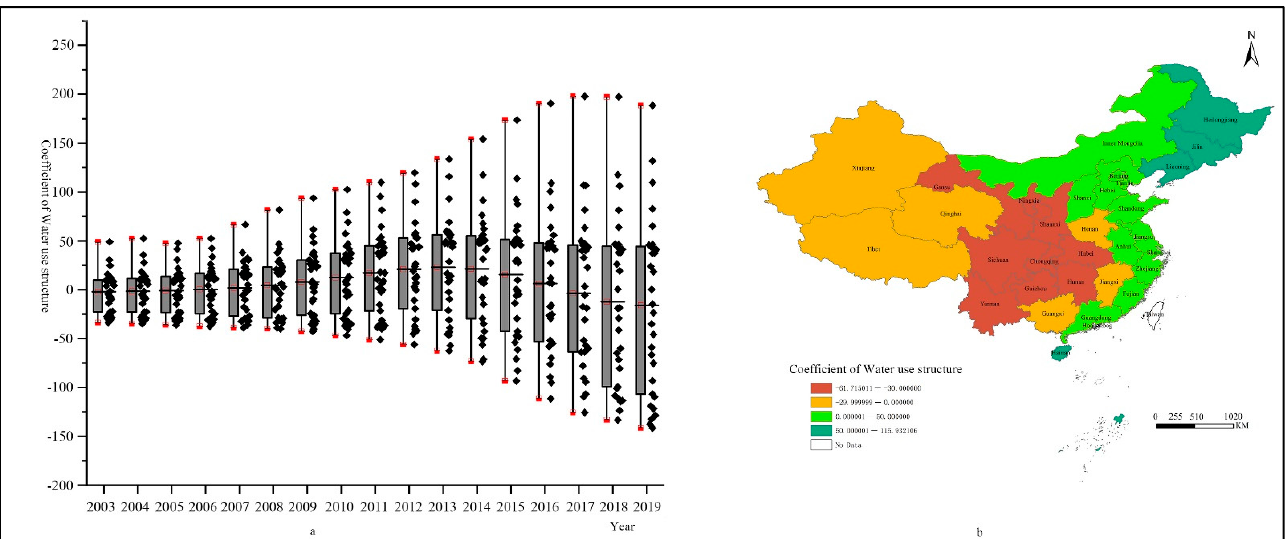
Figure 10. ( a ) Box-plot of regression coefficients of the water use structure; ( b ) Distribution of mean value of regression coefficients of the water use structure.